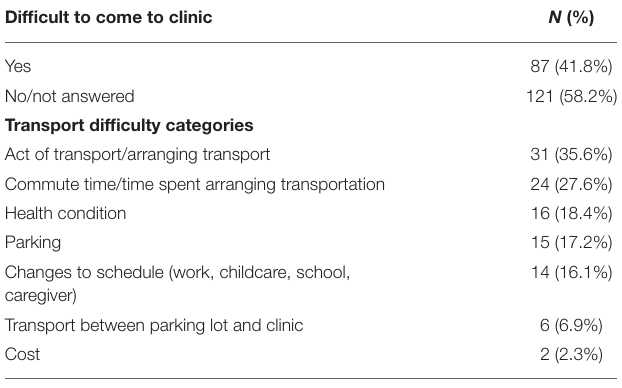
TABLE 2 | Barriers to clinic